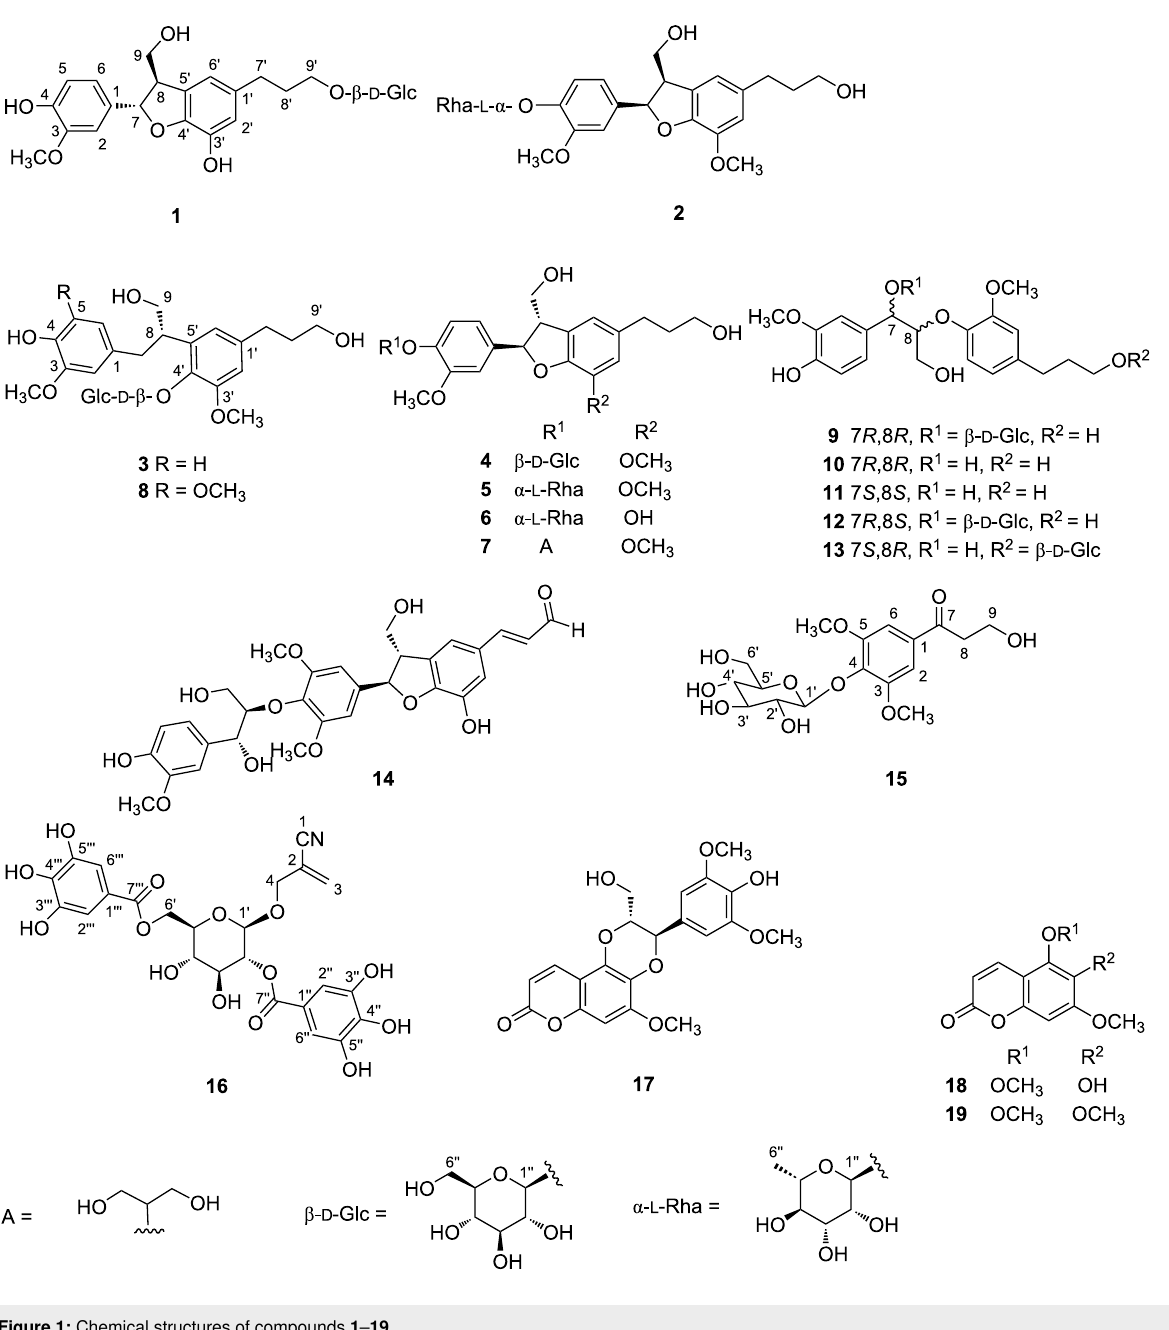
Figure 1: Chemical structures of compounds 1 – 19